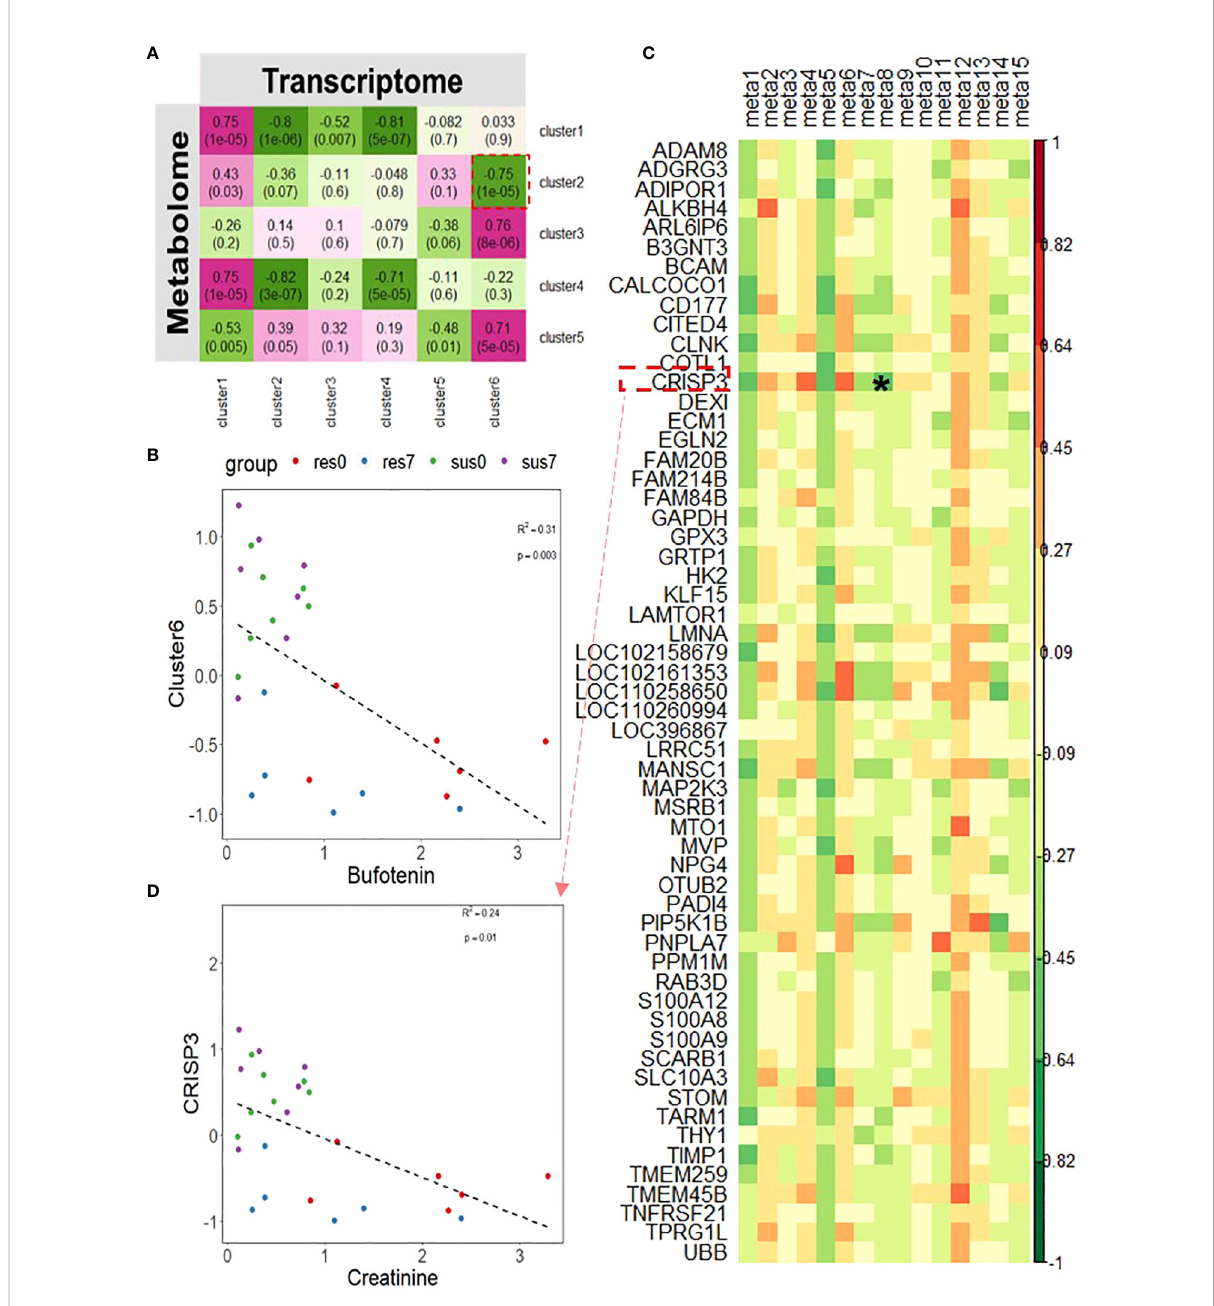
FIGURE 8 (A) Correlation between transcriptomic clusters of DEGs between resistant/susceptible pigs and metabolomic clusters; The magenta to green scale color indicates a positive to negative Pearson ’ s coef fi cient value, and coef fi cient values and the corresponding p-values are labeled on the boxes. (B) Correlation between bufotenin and transcriptomics cluster 6. (C) Correlation between DE metabolites in metabolomics cluster 2 and 5 and DEGs in transcriptomics cluster 2; the horizontal axis represents DE metabolites, and the vertical axis represents DEGs. Candidate combination of the metabolite and gene was marked by "*". (D) Correlation between creatinine and CRISP3. meta1~meta15 respectively represent metabolites in cluster 2 and 5: Bufotenin, (+)-7-Isojasmonic acid, 12-Hydroxydodecanoic acid, Myristic acid, Hexadecanedioate,